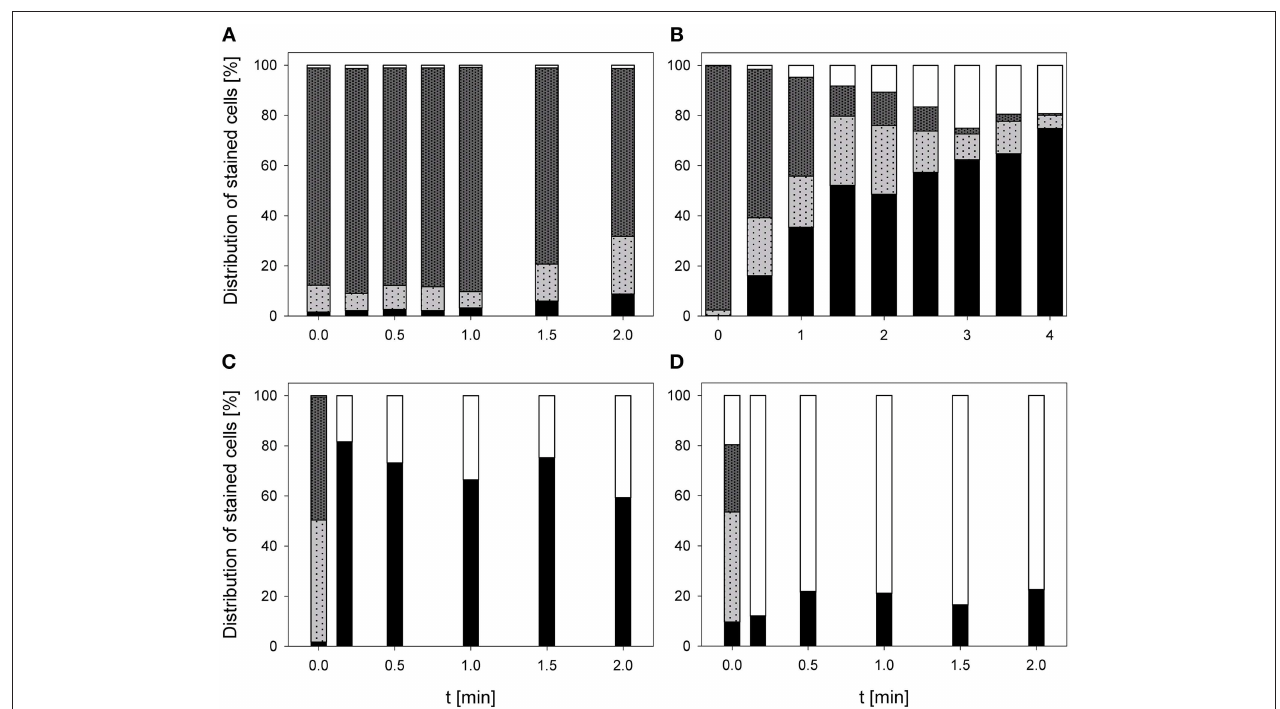
FIGURE 8 | Esterase activity and membrane integrity of L. innocua after PAA treatment [(A) 10 ◦ C, 0.25% PAA], CAPP treatment [(B) 20 W], treatment with ozonated water [(C) 3.42mg l − 1 O 3 (–); (D) 3.8mg l − 1 O 3 ( + )]. Black bars representing permeabilized cells without esterase activity; dotted gray bars representing permeabilized cells with esterase activity, dotted light gray bar representing intact cells with esterase activity, and white bars representing cells without fluorescence/cell